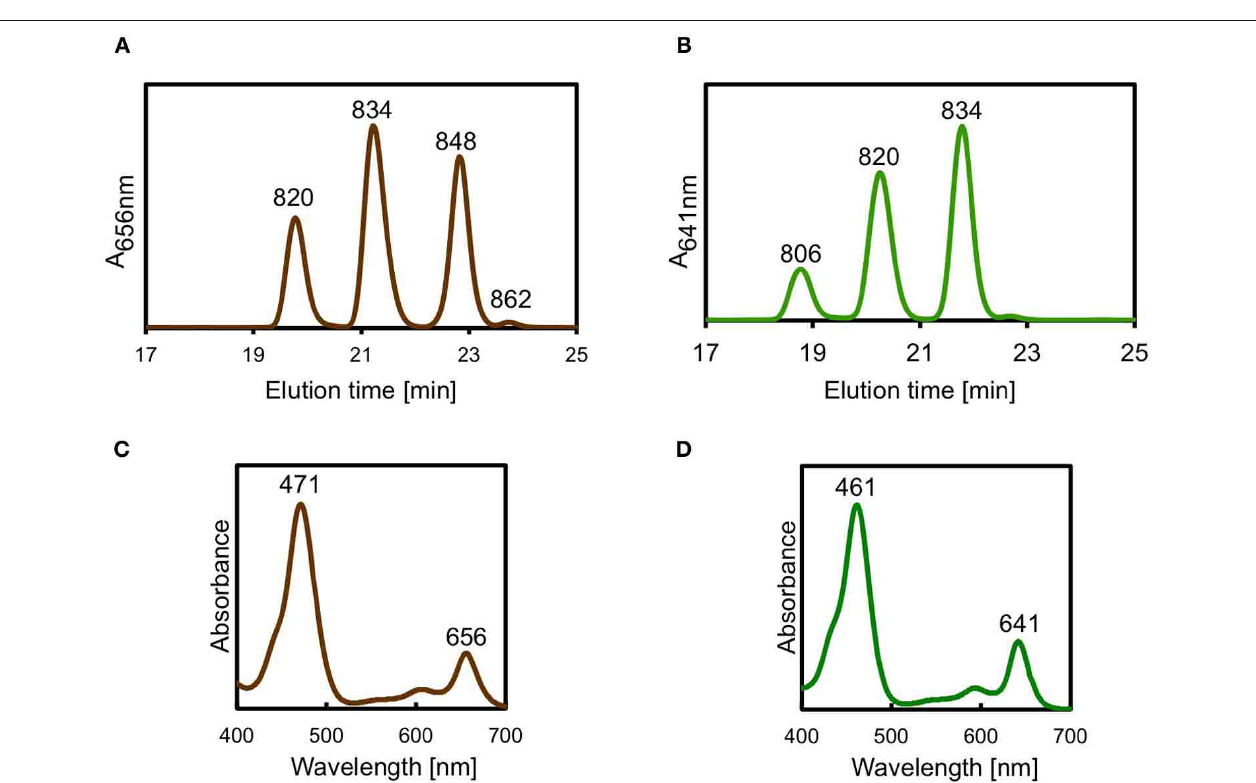
FIGURE 5 | Portion of HPLC elution profile for pigments extracted from C. limnaeum WT cells (panel A; monitored at 656nm) and for bchU mutant (panel B; monitored at 641nm). The four peaks in panel A had identical absorption spectra (panel C ); the m/z ratio of the BChls in each peak are indicated above and show that these are methyl homologs